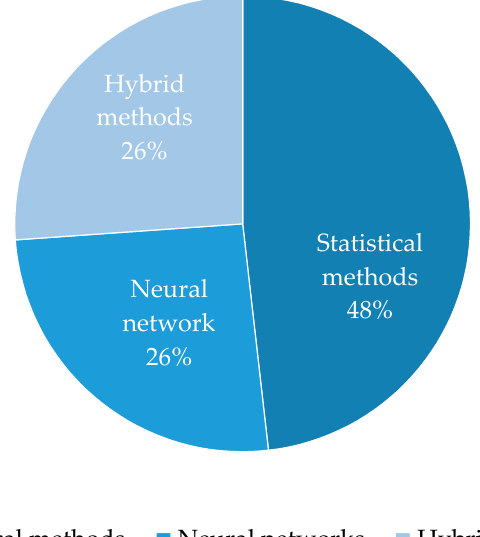
Figure 4. Distribution of articles on the forecasting of electricity prices according to the methodology used.